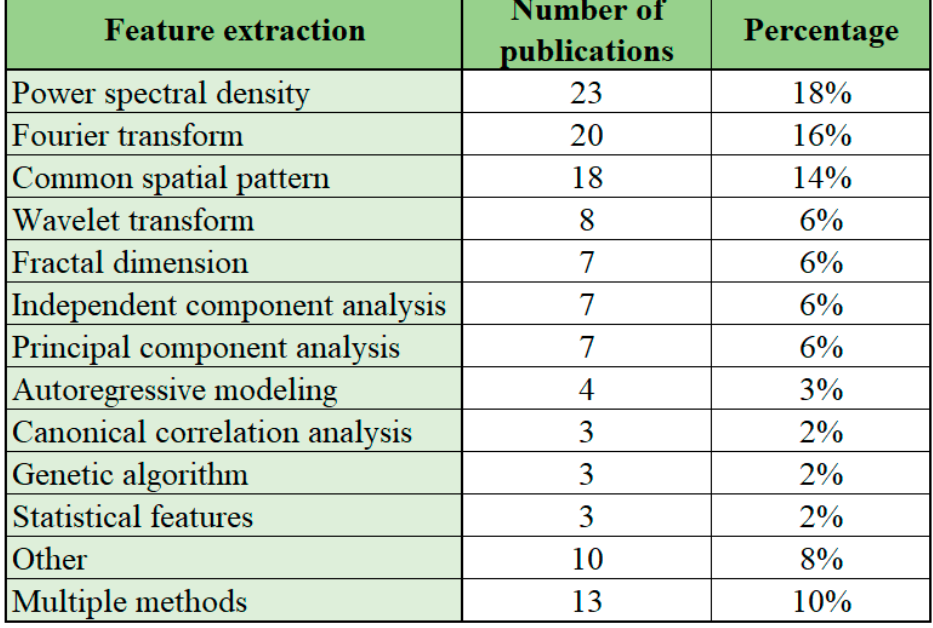
Figure 12. Feature extraction used in the publications ordered by the number and percentage of publications where the extraction method has been used.